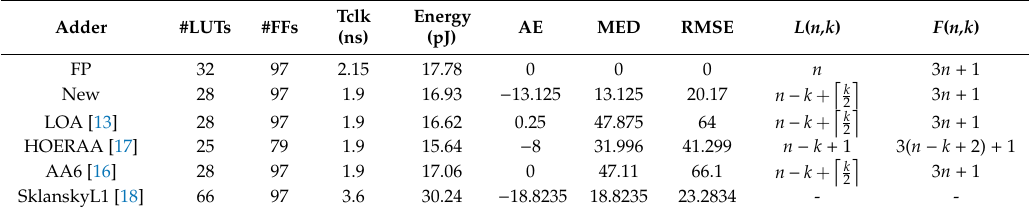
Table 2. Post-layout characterization results and error metrics of 32-bit signed adders for k =